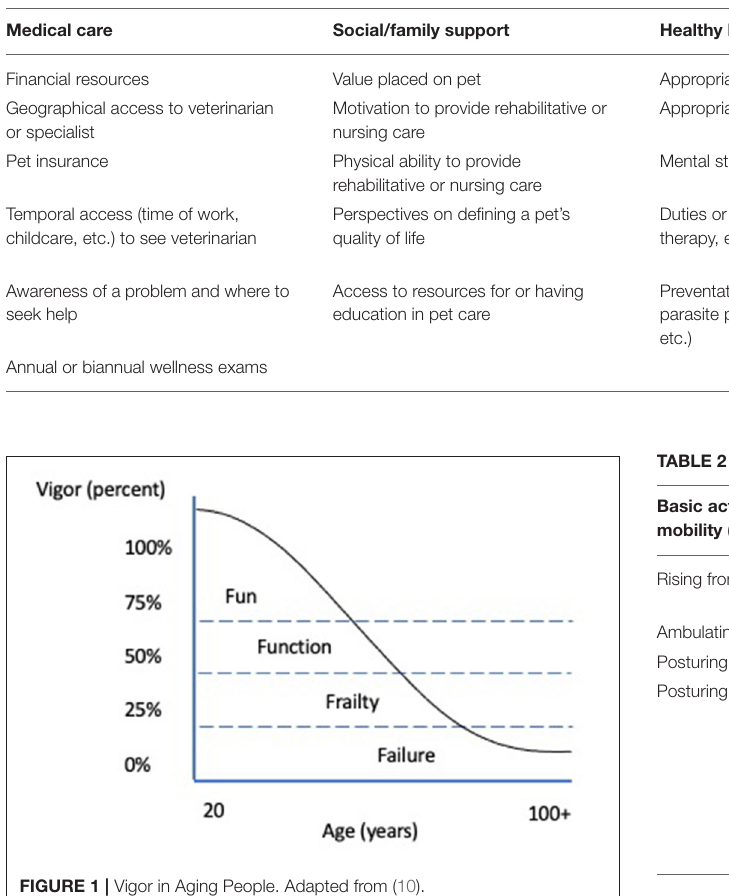
TABLE 1 | Variables affecting healthy aging in dogs.